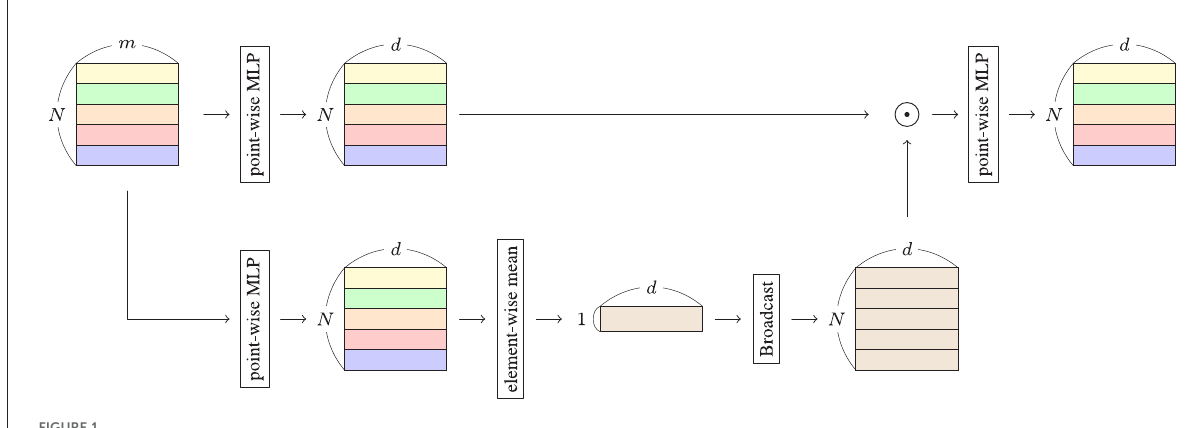
FIGURE1 Structure of relation system. Input data are in the form of a matrix respectively. Output data are in the form of a matrix